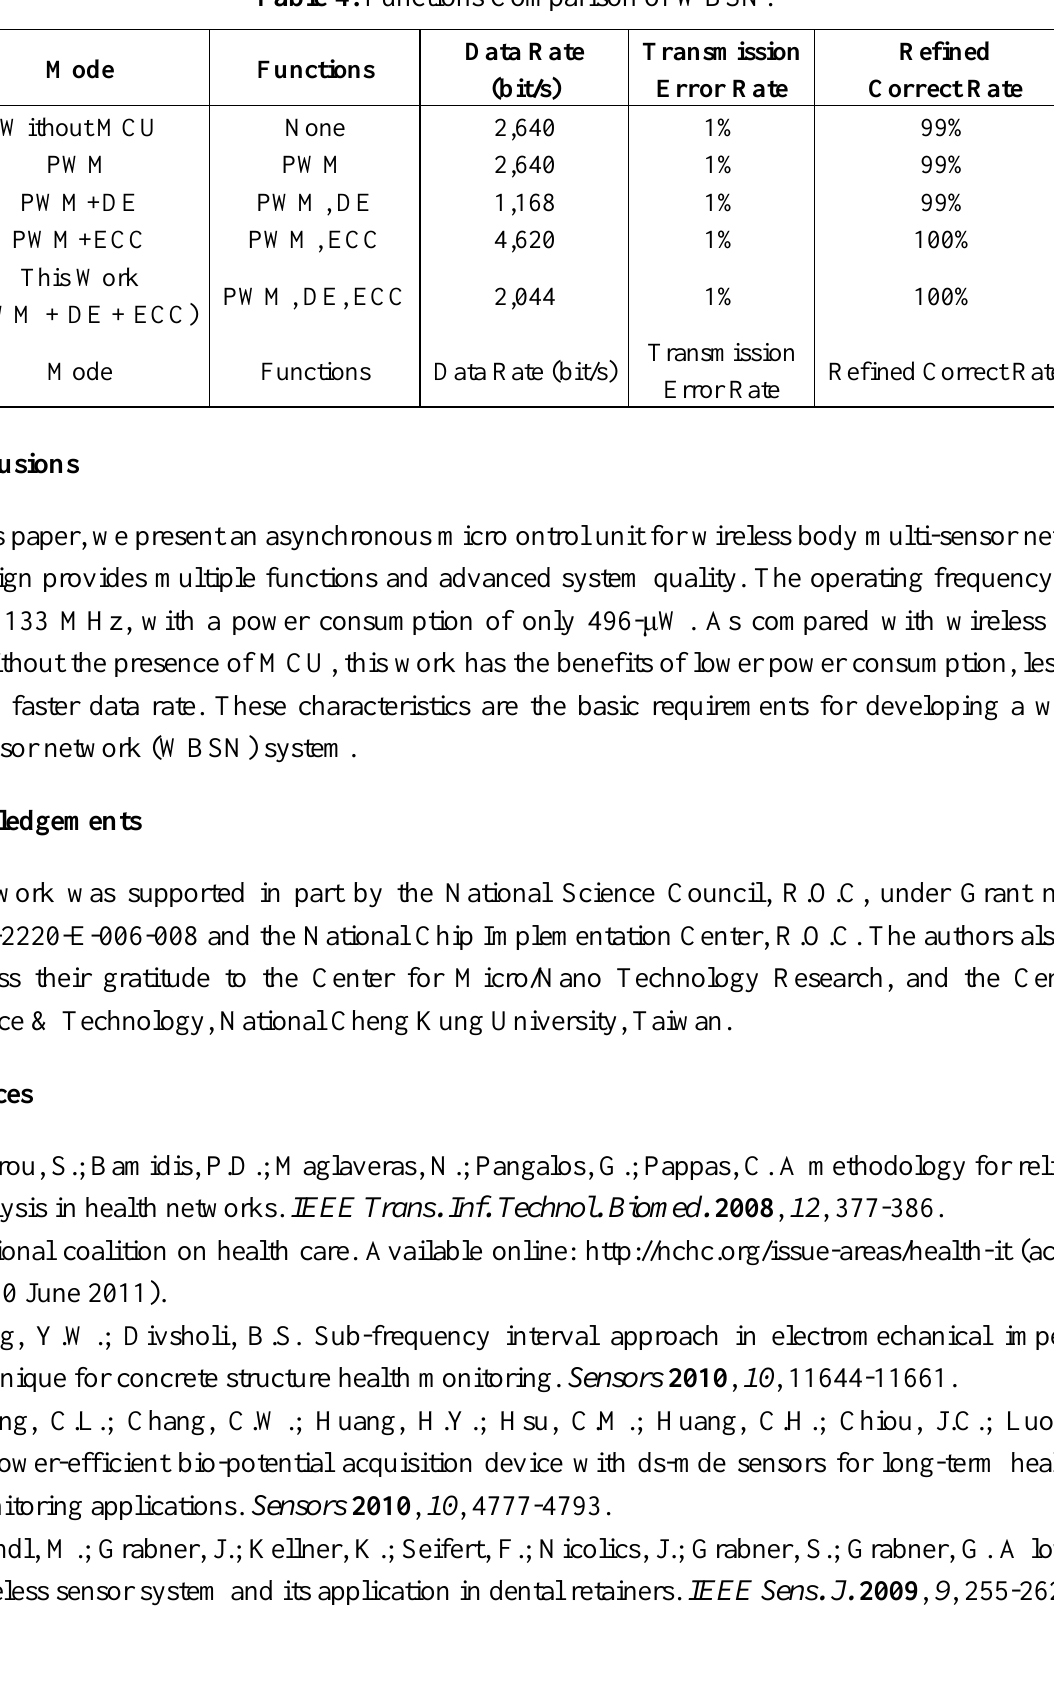
Table 4. Functions Comparison of